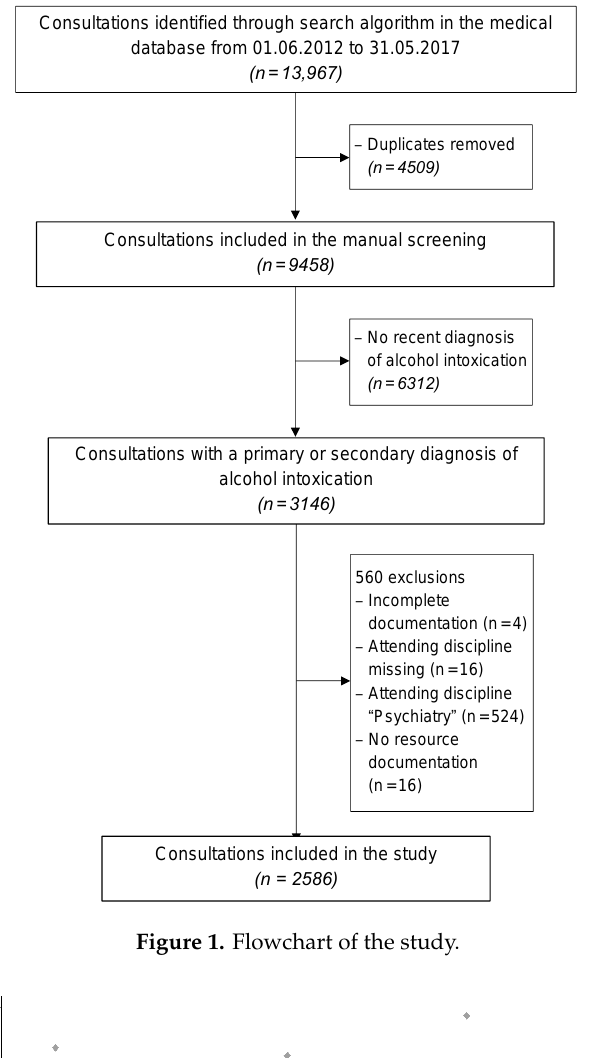
Table 1. Consultation characteristics of the group of patients ( n = 2586). Characteristic